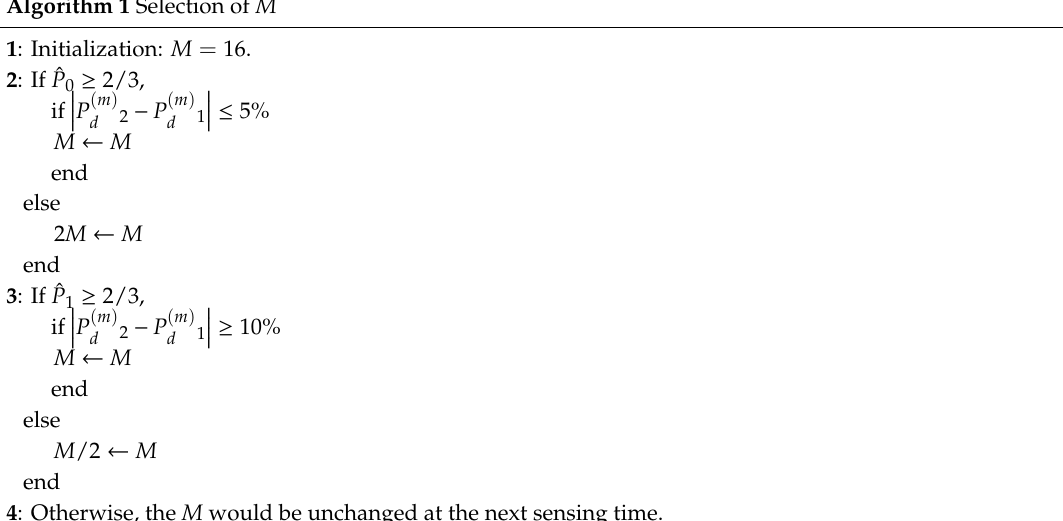
Algorithm 1 Selection of